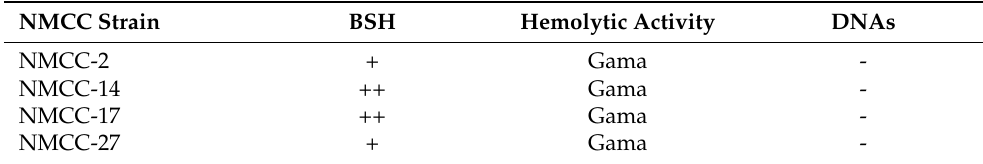
Table 4. Antibiotic resistance profiles of selected LAB strains.